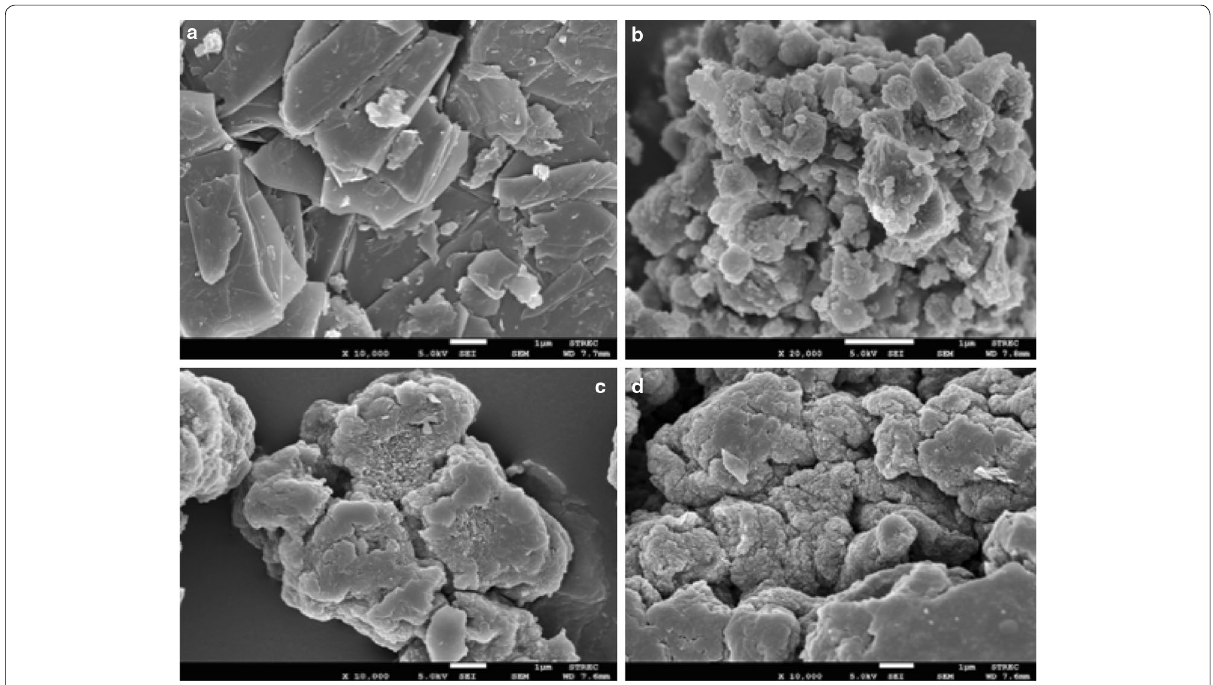
Fig. 2 SEM micrographs of a graphite, b graphene oxide, c reduced graphene oxide and d silver-adhered reduced graphene oxide